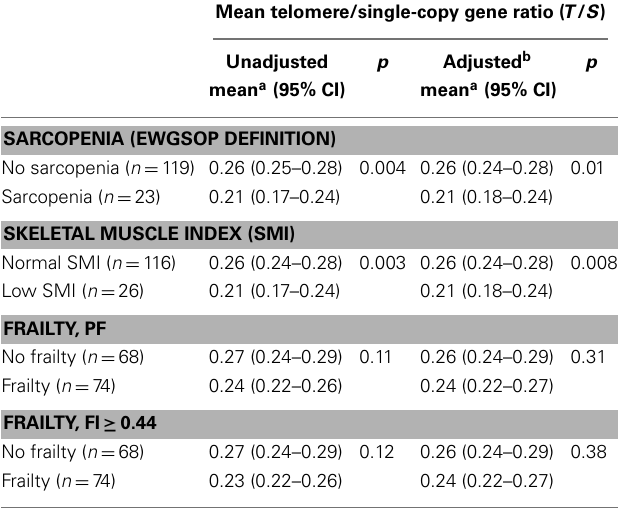
Table 4 | Mean telomere/single-copy gene ratio ( T / S ) values according to sarcopenia, skeletal muscle index, and frailty status .